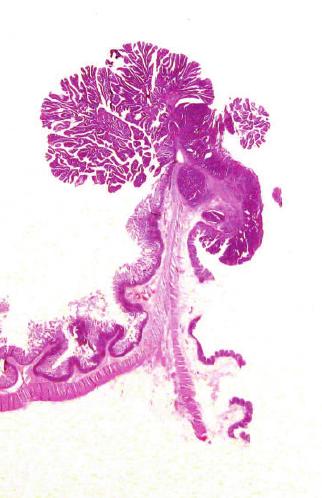
Figure 7: Large format section from an intestinal adenomatous polyp with adenocarcinoma. The level of invasion by the adeno- carcinomatous area is easily assessed.